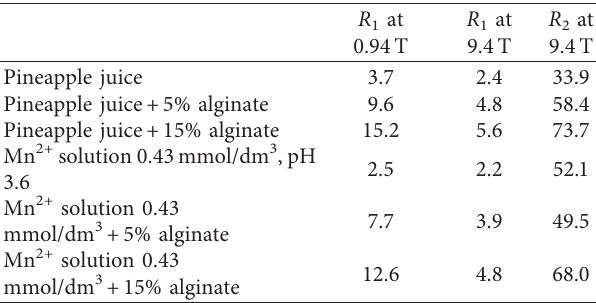
Table 3: Relaxation rates (s − 1 ) at 37 ° C measured for pineapple juice and Mn 2+ solutions without and with